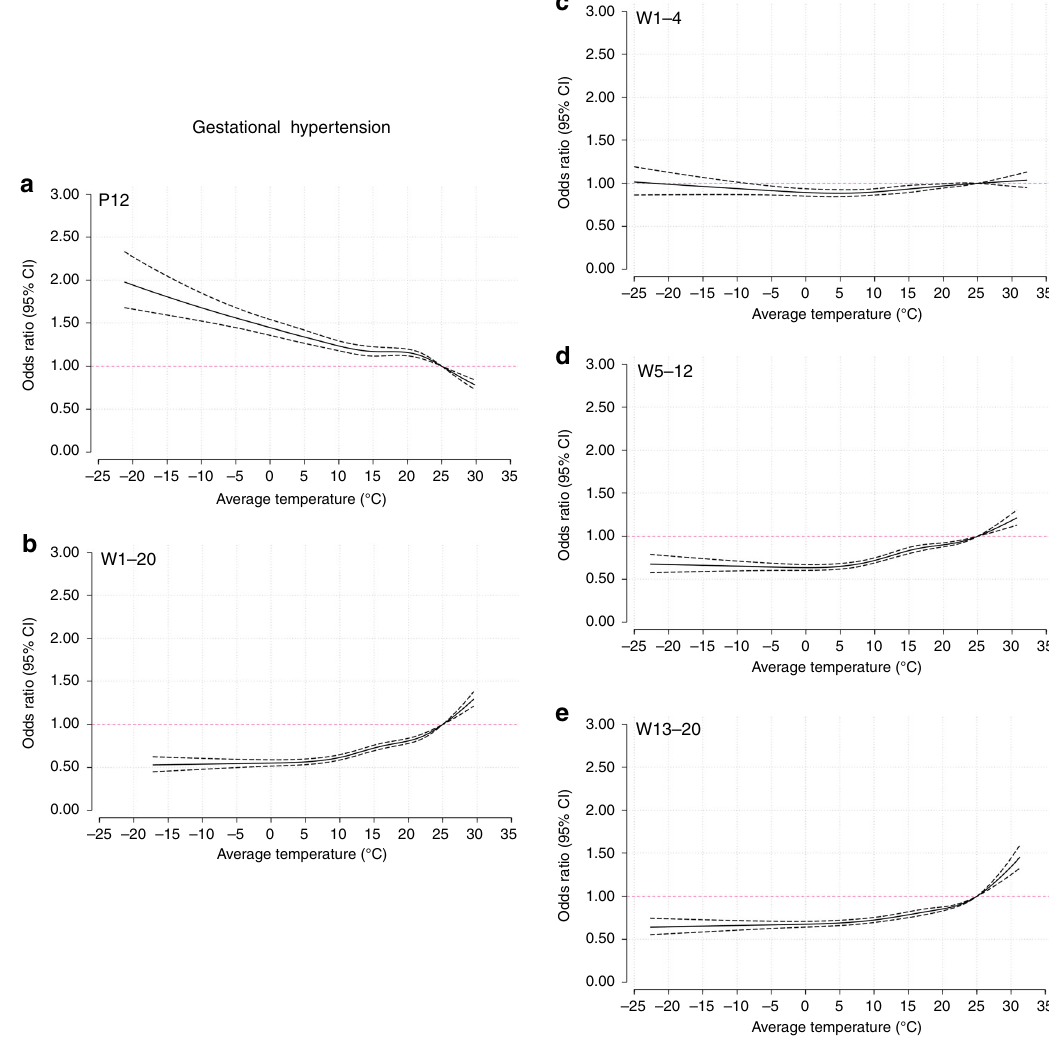
Fig. 3 Curves of the associations between average temperatures and gestational hypertension. Solid black lines correspond to points estimate of aORs of gestational hypertension; dashed black lines correspond to 95% con fi dence intervals. a 12 weeks preconception; b 1 – 20 weeks postconception; c 1 – 4 weeks postconception; d 5 – 12 weeks postconception; e 13 – 20 weeks postconception. PC preconception, W weeks postconception. Source data are provided as a Source Data fi